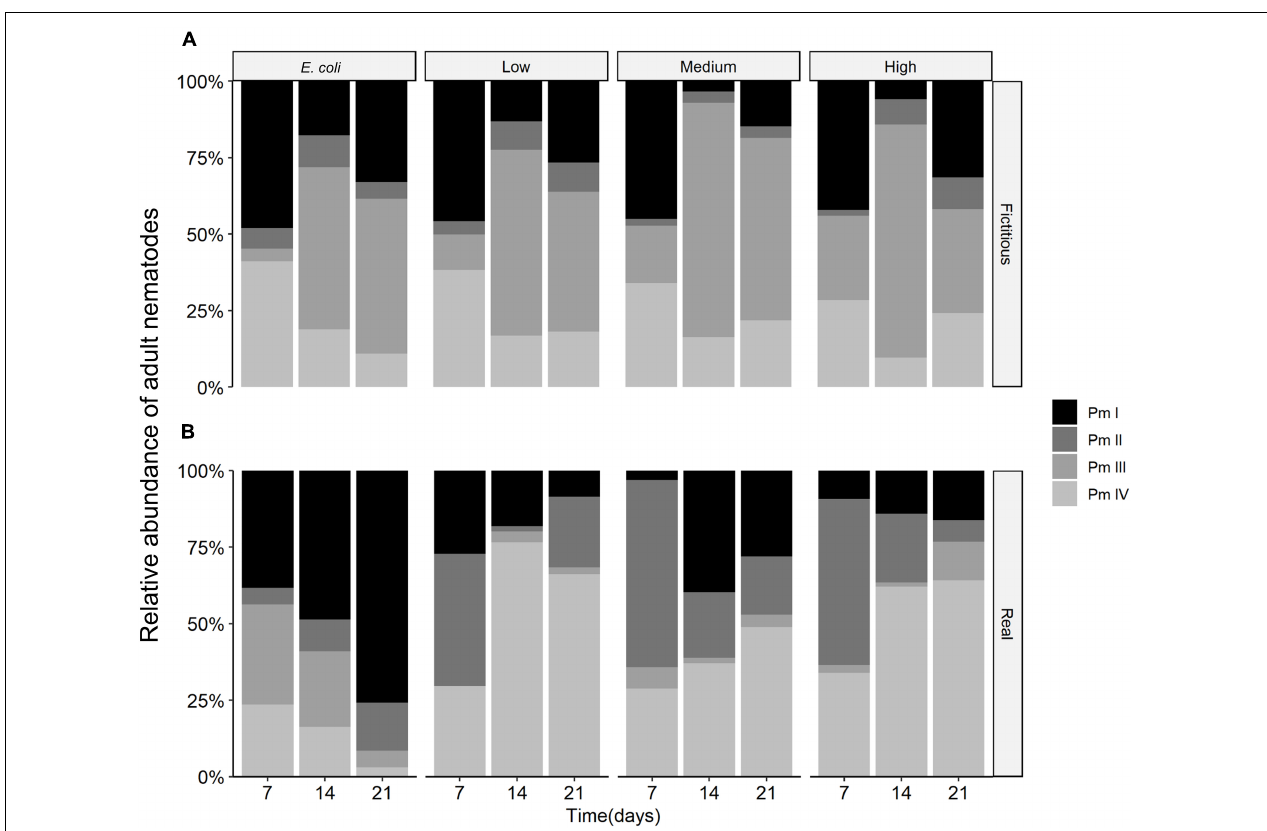
FIGURE 7 | Average relative abundances of adult nematodes in (A) fictitious (based on the results of the monospecific cultures) and (B) real multispecies cultures at each time moment (7, 14, and 21 days) in different food treatments ( E. coli , low diversity, medium diversity, and high diversity) ( n = 4 ).